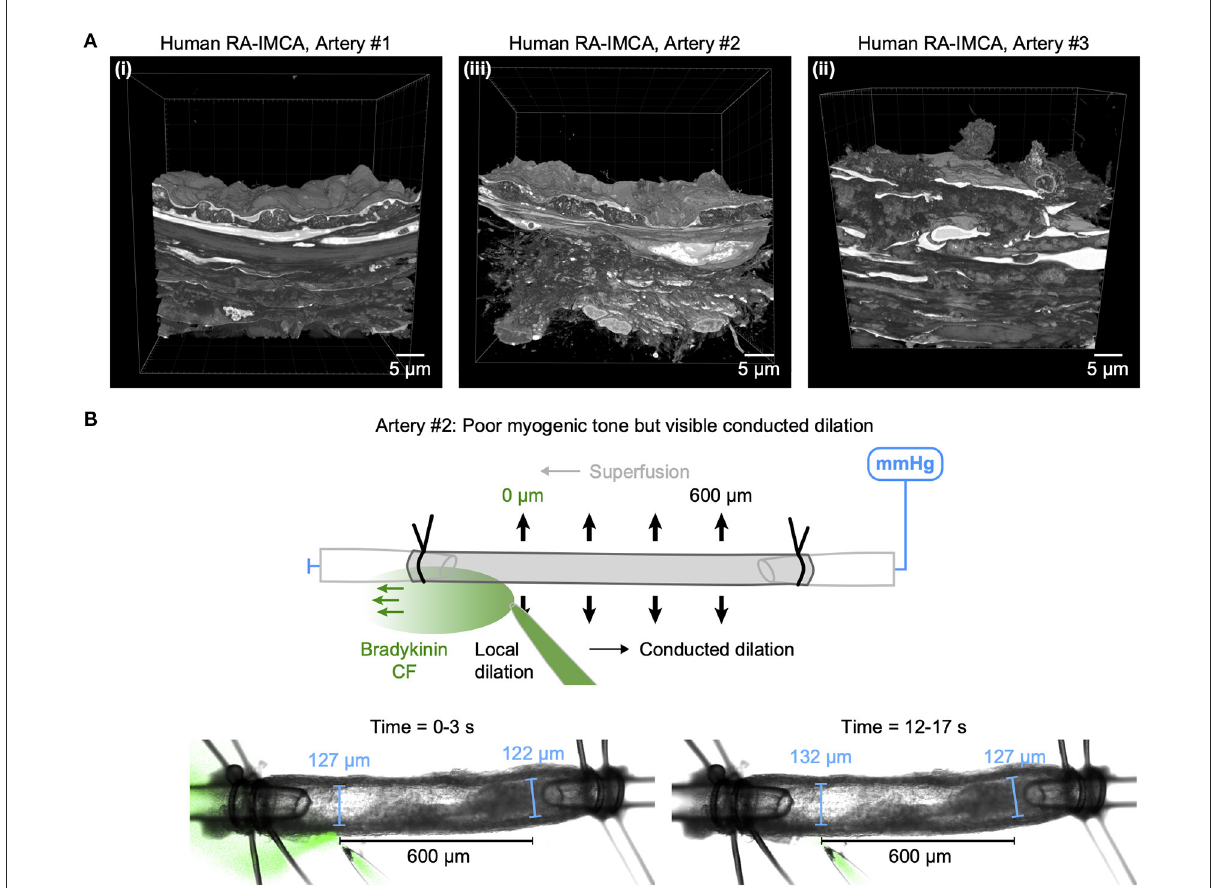
FIGURE10 Cell-cell contacts enable conducted dilation in a human RA-IMCA with poor contractile function. (A) SBF-SEM 3D stacks of the wall of three RA-IMCAs, Artery #1 to #3 (Table 2), also shown in in Dora et al. (18), including z-stack movies. (B) While Artery #2 did not develop